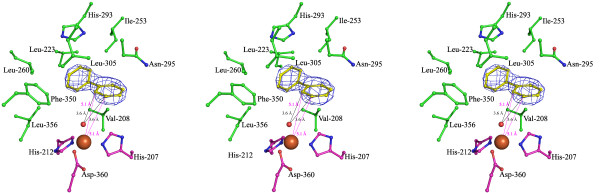
BPDO-OB1 bound to biphenyl. Stereo image of the active site of BPDO-OB1 with biphenyl bound. The biphenyl molecule is shown in yellow. A 1.0 σ 2Fo-Fc electron density map calculated without biphenyl present (unbiased) is shown in blue mesh for the biphenyl ligand. The residues that coordinate the mononuclear iron are shown in red, while the residues that form the active site pocket are shown in green. Black lines show distances between the biphenyl carbons and the mononuclear iron and red lines show distances between the biphenyl carbons and the water/hydroxide bound to the mononuclear iron. Left and center images are wall-eyed stereo, center and right images are cross-eyed stereo.